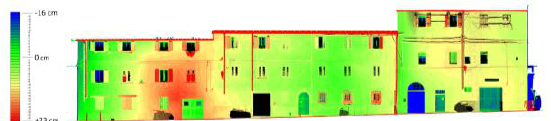
Figure 9. Out-of-plane deformation of a façade of the masonry aggregate.